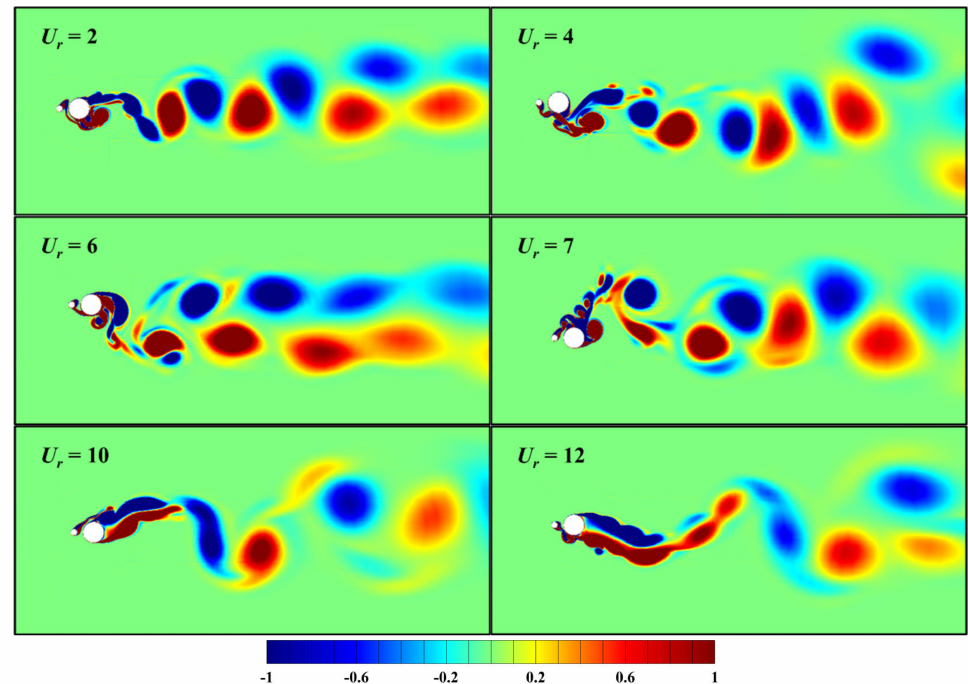
Figure 13. Instantaneous vorticity field for two coupled cylinders at α = 180 ◦ and d/D = 0.3. At α = 0 ◦ , the vortices shedding from the large cylinder impinge on the small cylinder and separate on the top and bottom sides due to the dominant streamwise motion at U r =